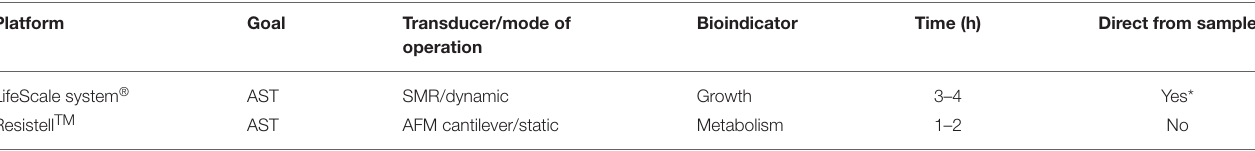
TABLE 3 | Commercial nanomechanical platforms for bacteria detection and AST. Platform